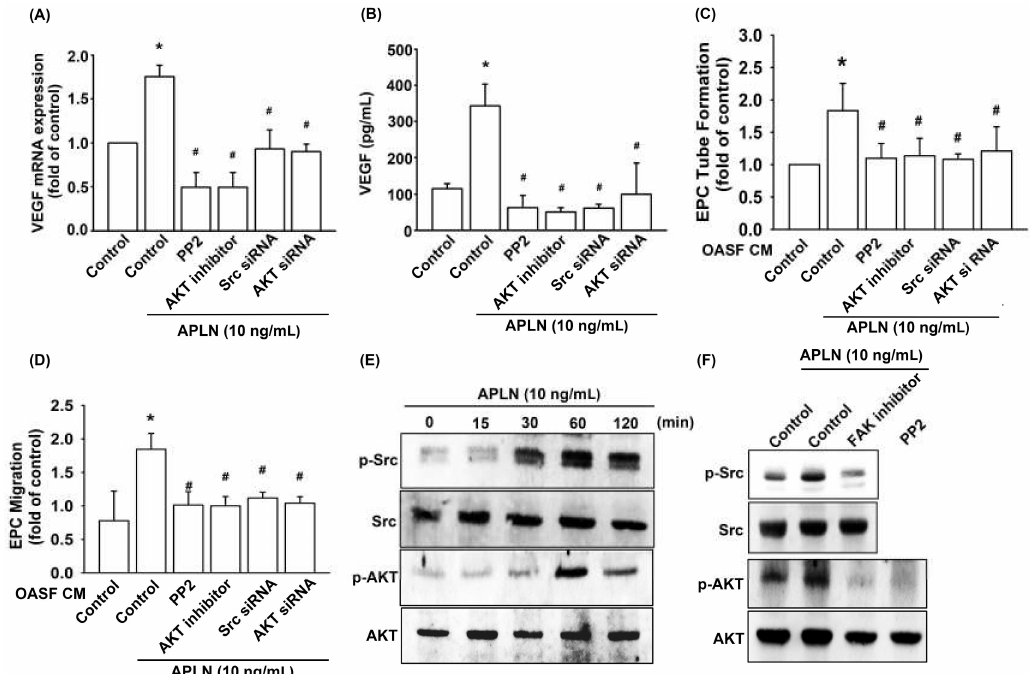
Figure 4. Src and Akt phosphorylation are involved in APLN-induced VEGF synthesis. ( A , B ) OASFs were pretreated with Src / Akt inhibitors for 30 min or Src / Akt siRNAs for 24 h, then incubated with APLN for 24 h. ( A ) VEGF mRNA levels were examined using RT-qPCR ( n = 4), and ( B ) excreted VEGF protein levels were quantified using ELISA assay ( n = 5). ( C , D ) After pretreatment with Src / Akt inhibitors or Src / Akt siRNA and incubation with APLN, the culture medium was collected and subjected to EPC ( C ) tube formation ( n = 5) and ( D ) migration assays ( n = 5). ( E ) OASFs were incubated with APLN, and the extent of Src / Akt phosphorylation was examined using Western blot analysis ( n = 3). ( F ) OASFs pretreated with a FAK inhibitor before APLN incubation were assessed for the extent of Src / Akt phosphorylation, while OASFs pretreated with a Src inhibitor before APLN incubation were assessed for Akt phosphorylation ( n = 3). * p < 0.05 compared with control; # p < 0.05 compared with the APLN-treated